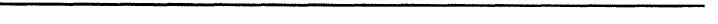
Fig. 11. C. barozzii; shingle-like arrangement of several groups of microtrichia on median portion of fourth abdominal sternite, approximately midway between its anterior (towards .top) and posterior (towards bottom) boundaries. Arrow indicates where tips of hairs, mostly concealed by debris, appear to be interspersed among groups of microtrichia. Scale line #m. Fig. 12. C. barozzii; large numbers of fringed se.tae on lateral edge of sixth ventral abdominal paratergite, left side of body. Arrow indicates edge of body. Scale line 10